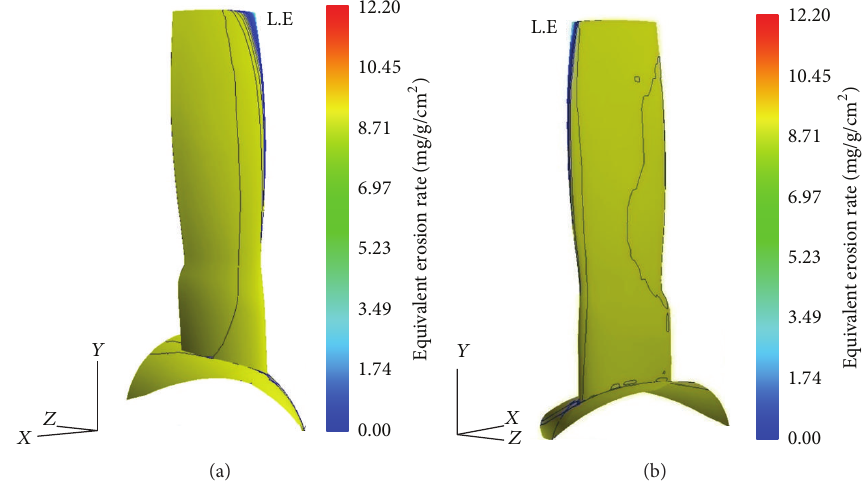
Figure 13: Equivalent erosion rates (mg/g/cm 2 ) at high concentration (500mg/m 3 ): (a) Suction side and (b) pressure side.